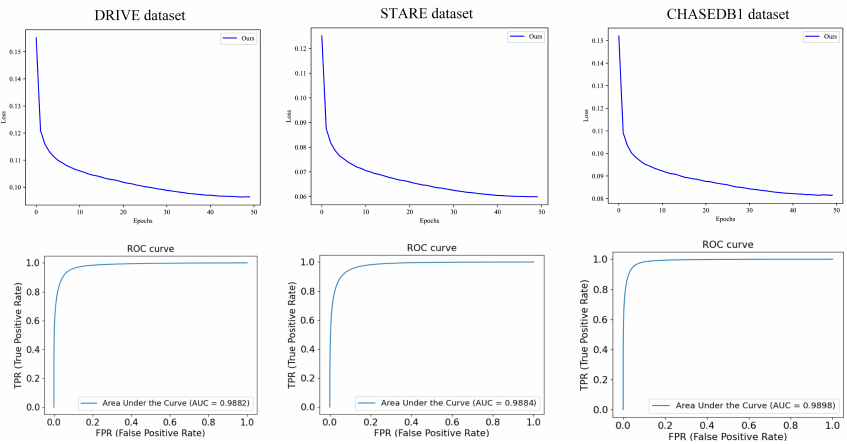
Figure 4. Loss curve and ROC curve on three